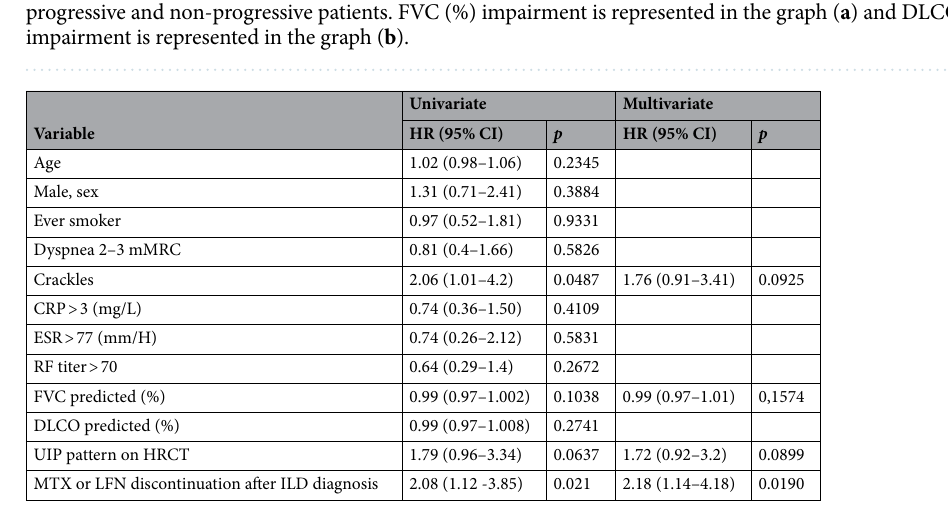
Table 2. Cox analysis of progression predictors. mMRC: modified Medical Research Council; ESR: erythrocyte sedimentation rate ; CRP: C-reactive protein; RF: rheumatoid factor; FVC: forced vital capacity; DLCO: diffusion capacity for carbon monoxide; UIP: usual interstitial pneumonia; HRCT: high-resolution computed tomography; MTX: methotrexate; LFN: